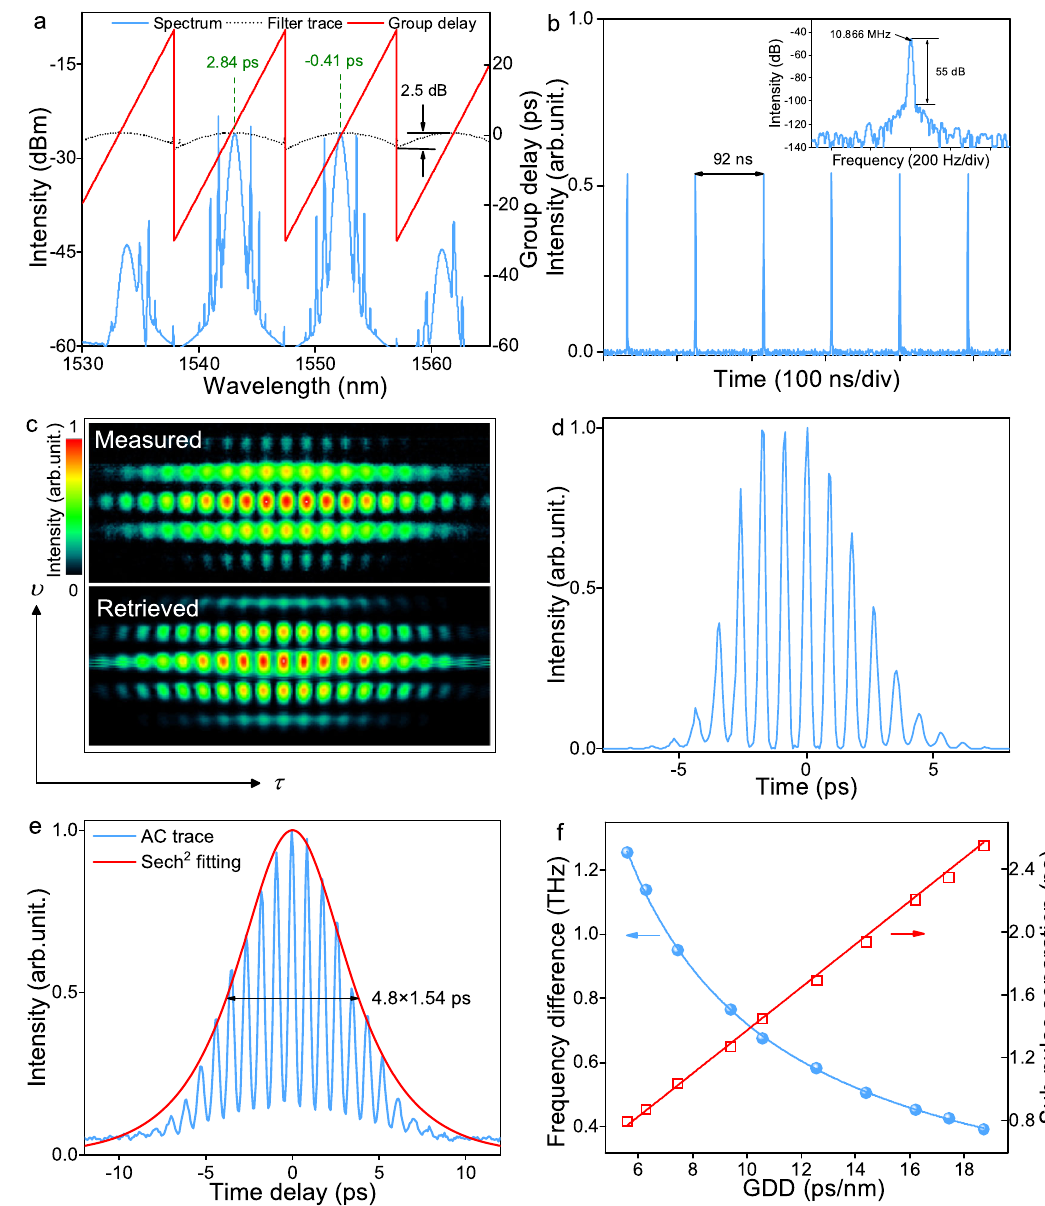
Fig. 2 Experiment results of synchronized dual-wavelength mode-locked solitons. a Spectrum of pulses, fi ltering and group delay imparted by the PPS. The imparted group delay difference between two spectra is 3.25 ps, for partially compensating that induced by the intrinsic dispersion of PPS and cavity. b Pulse train and radio frequency spectrum of the wavepacket. c Measured (upper panel) and retrieved (lower panel) FROG spectrograms. d Retrieved pulse pro fi le. e Autocorrelation (AC) trace and the Sech 2 fi tting. f Frequency difference and sub-pulse separation versus imparted